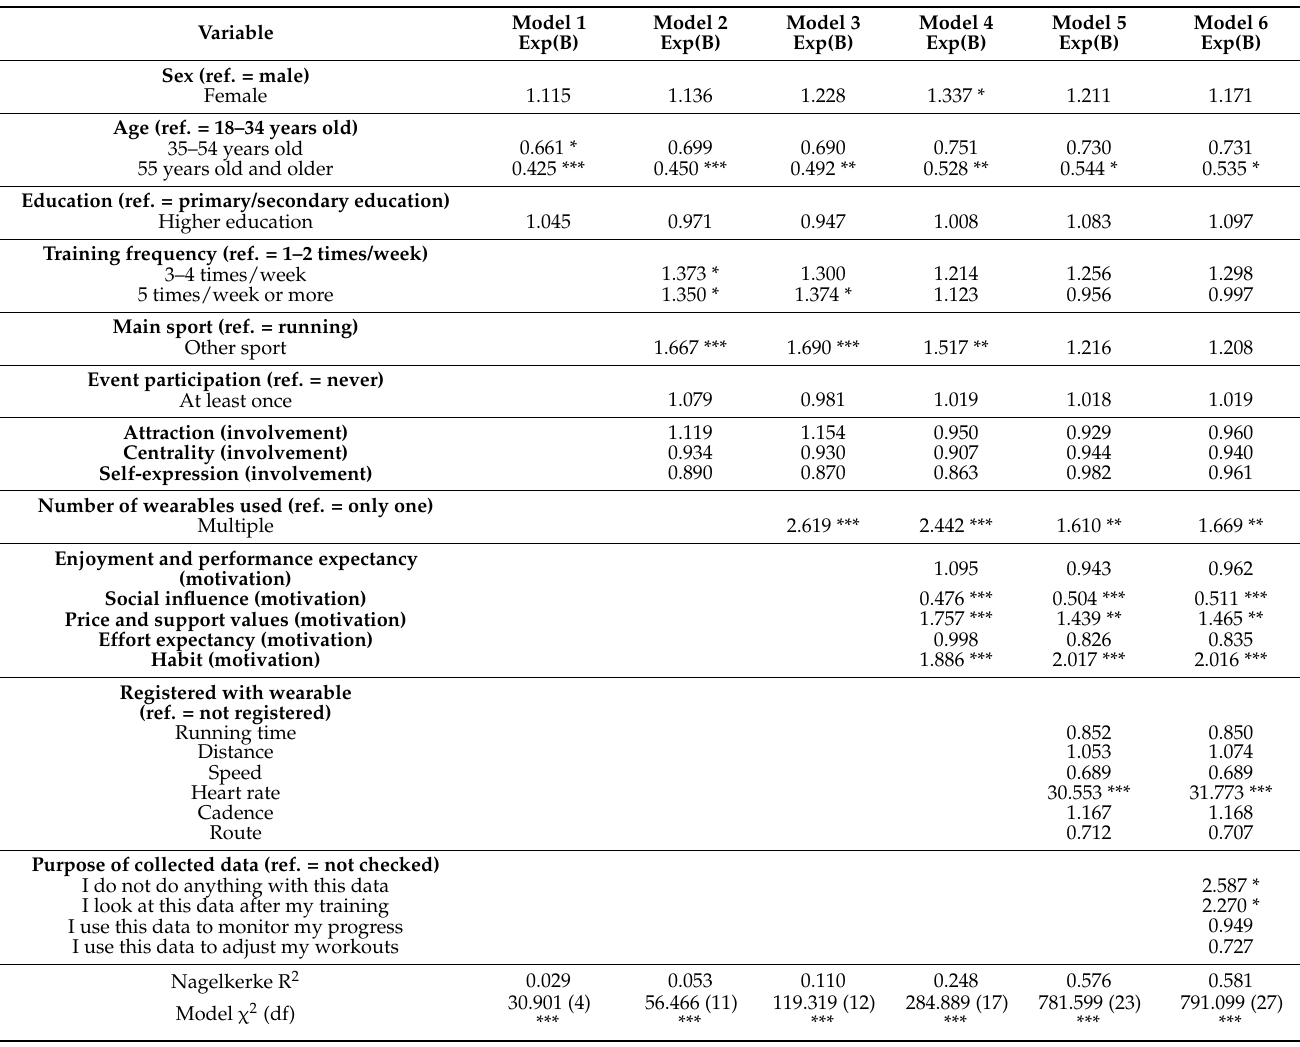
Table 6. Binary logistic regression for the most important wearable among walking participants: use of applications (=0) or (sports)watches/smartwatches (=1) (N weighted = 1628).